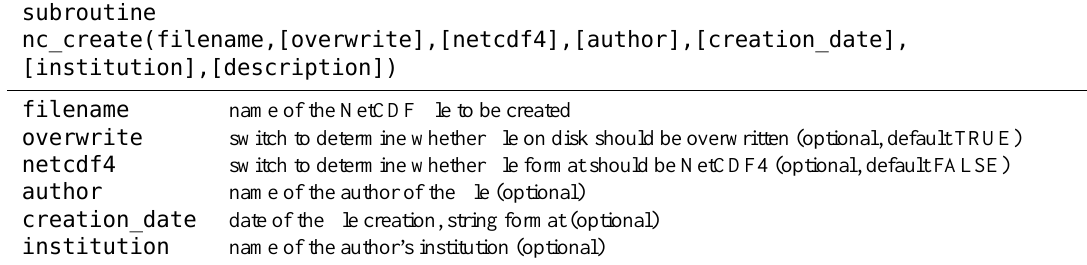
Table A4. Subroutine call and argument descriptions for nc_create